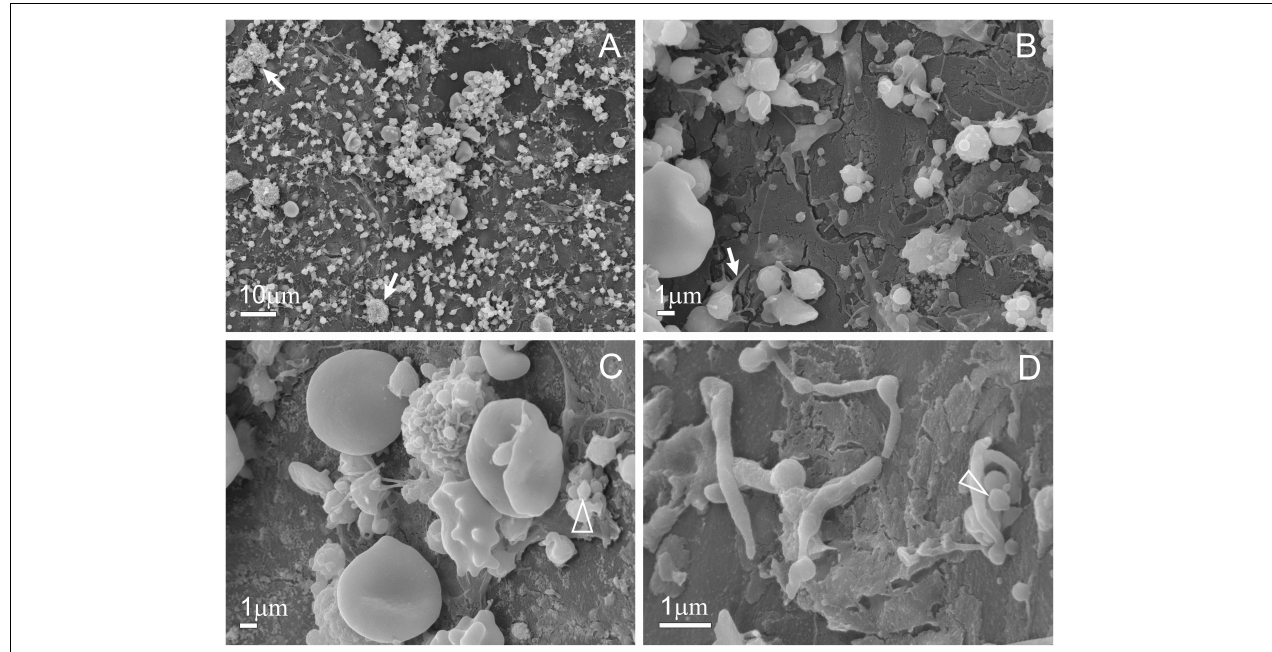
FIGURE 5 | Scanning electron microscopy of PVRP. Panel (A) depicts high platelet and extracellular vesicle (EV) count. The white arrow on panel (A) depicts leukocytes, the white arrow on panel (B) depicts a platelet forming a tubular protrusion prior to EV shedding, triangles on panels (C,D) depict EVs. Panel (D) depicts platelets and EVs, which are globular fragments sized 300–1,000 nm, formed after platelet activation and shedding of their tubular protrusions. PVRP: platelet- and extracellular vesicle-rich